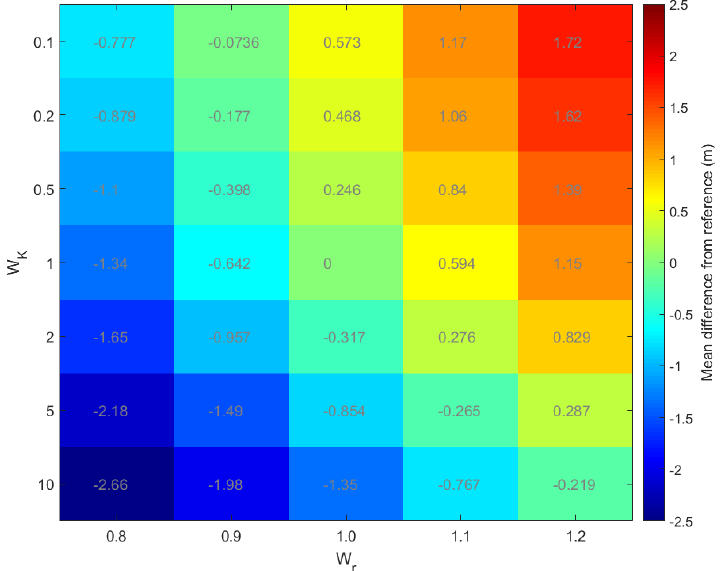
Figure 16. Mean water table difference plot for 35 model runs, with varying weights for recharge ( W r ) and K ( W K ). Difference is compared to the reference run of W r = 1 and W K =